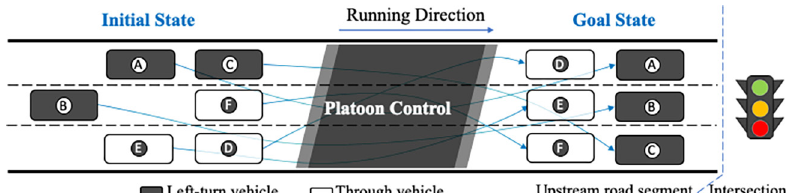
Figure 4 Platoon control at signalized